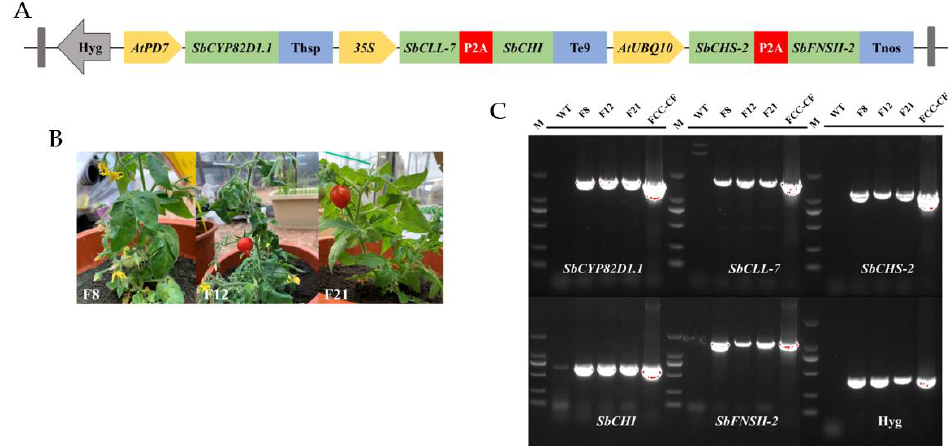
Figure 2. Agrobacterium transformation of Micro-Tom tomato plants with baicalein biosynthesis genes. ( A ) T-DNA region of the multigene vector FCC-CF that was transformed into the Micro-Tom tomato plants. ( B ) Transgenic Micro-Tom lines (F8, F12 and F21). ( C ) PCR detection of five baicalein biosynthesis genes and Hyg genes. The wild-type (WT) was not transformed with Agrobacterium . F8, F12 and F21 were transgenic Micro-Tom lines. FCC-CF was the recombination plasmid. M represented the 2000 bp maker.